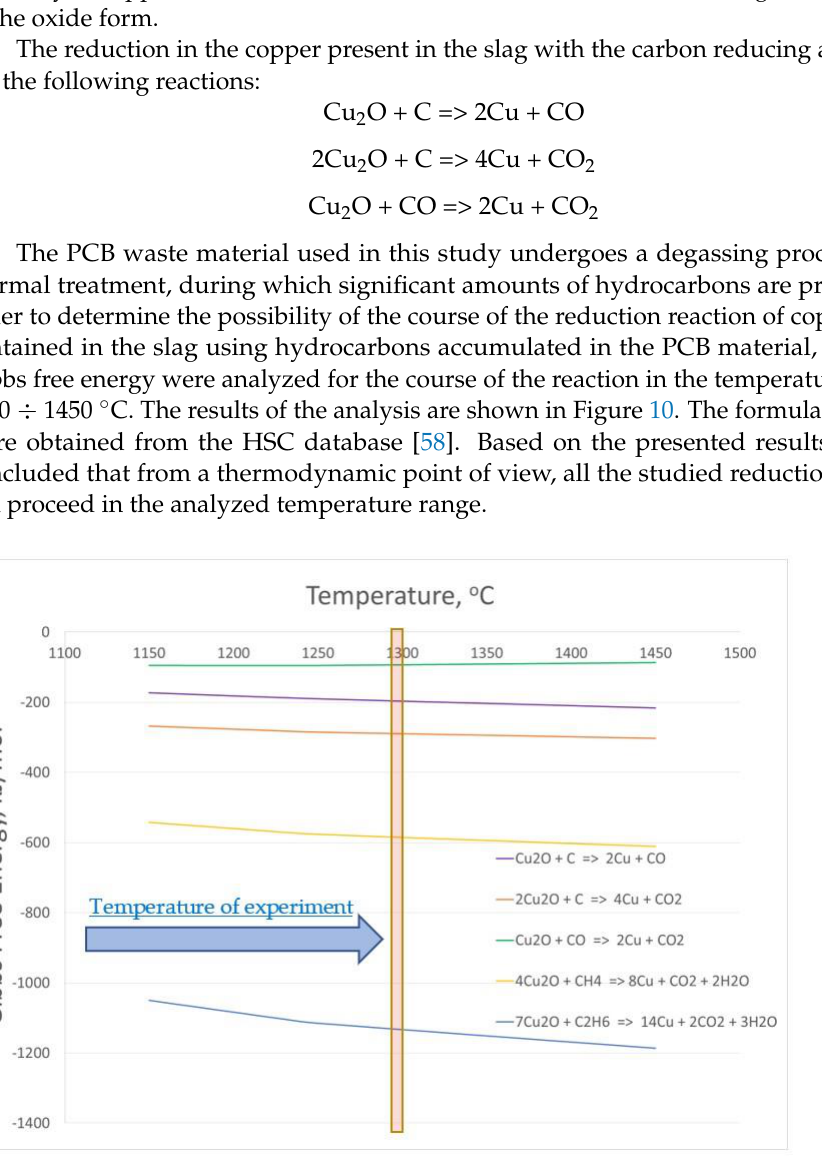
Figure 10. Gibbs free energy change for selected Cu 2 O reduction reactions.